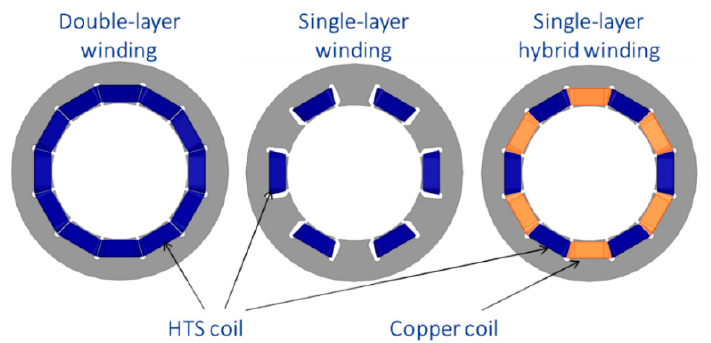
Figure 10. Different structures of armature winding designs for PM-excited machines. Reproduced with permission from [108], IOS Press, 2022.